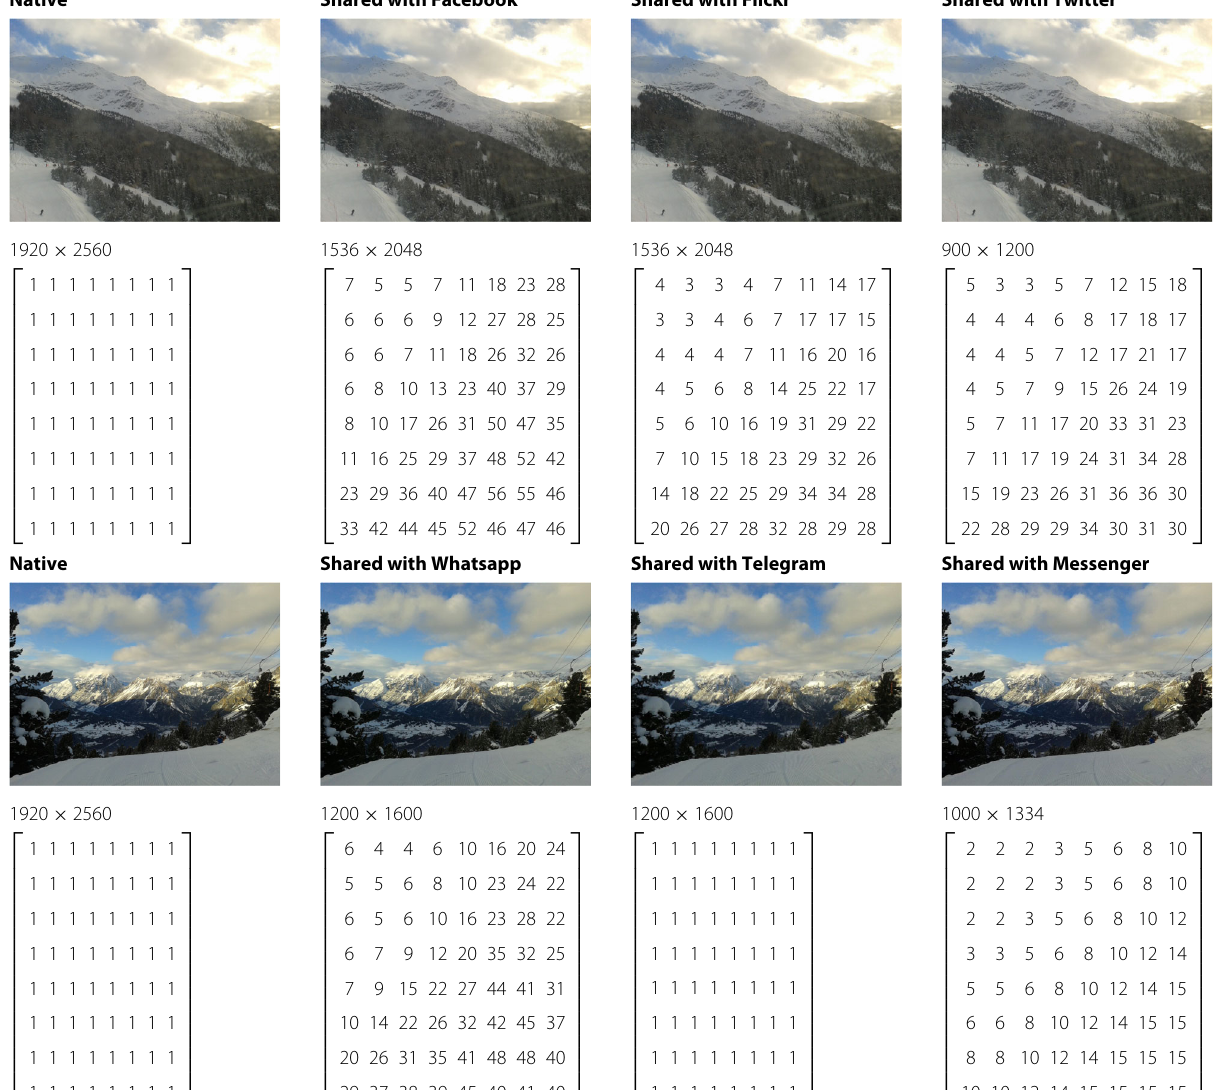
Table 1 Examples images before and after being shared and downloaded from social media platforms. The image size and the luminance quantization tables used for the last JPEG compression are reported in each case, showing notable differences between different versions Native Shared with Facebook Shared with Flickr Shared with